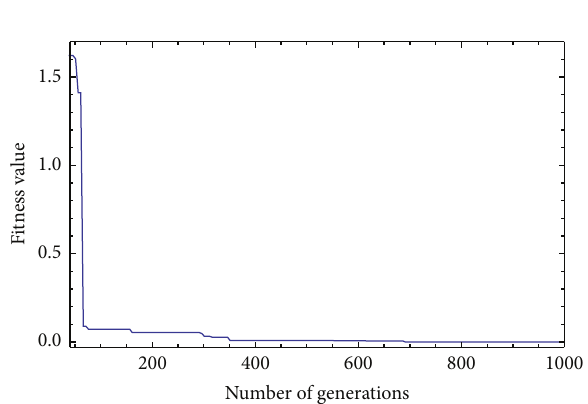
Figure 17: Performance graph for Case 7.